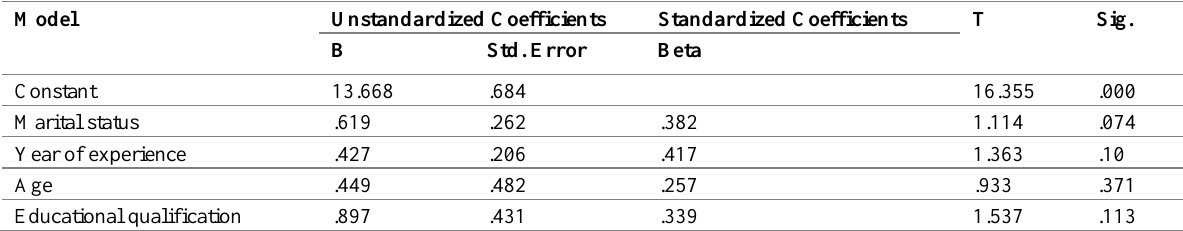
Table 5: Regression Analysis Showing Influence of Marital Status, Year Of Experience, Age And Educational Qualifications Of